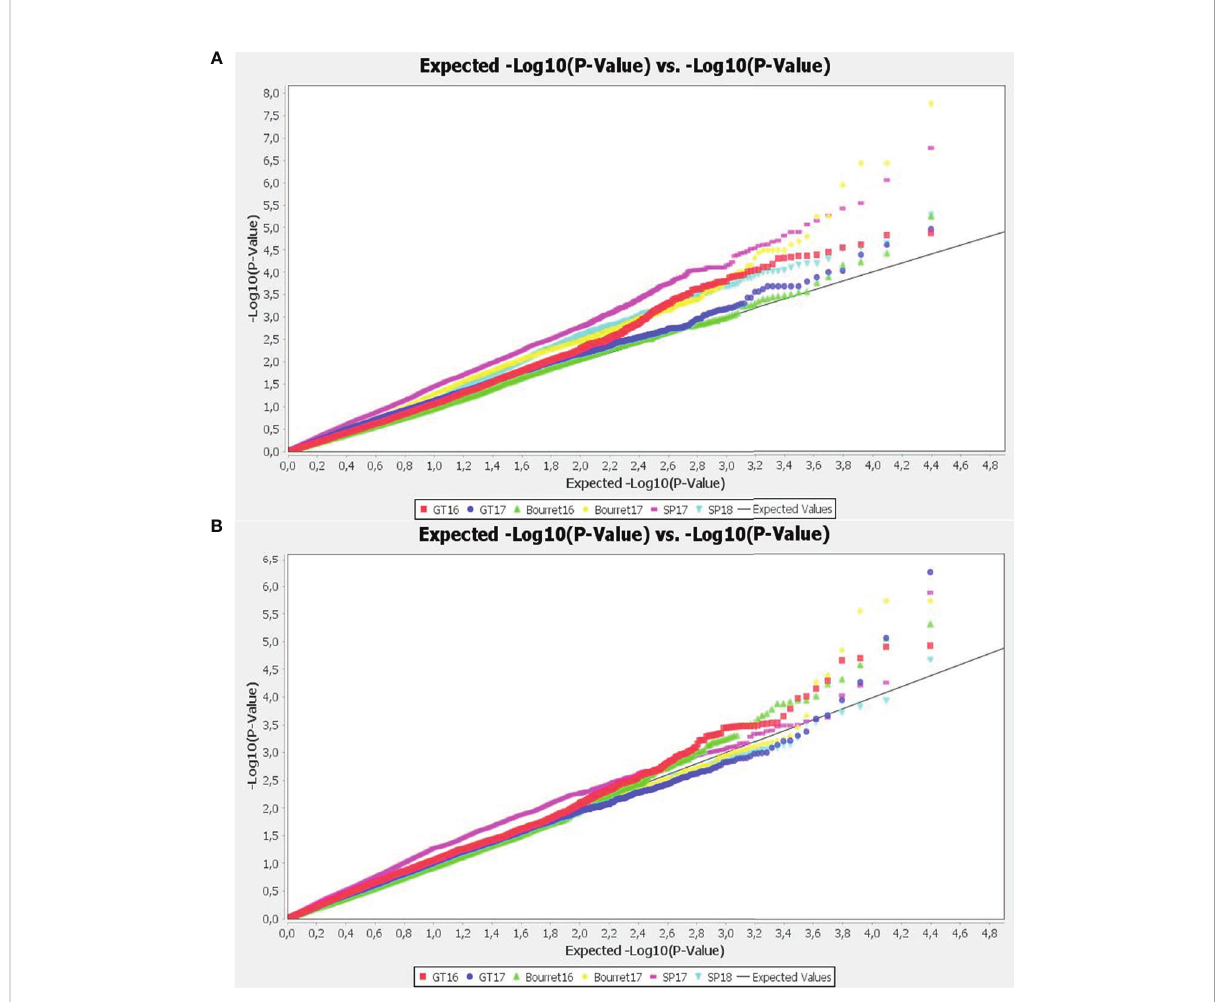
FIGURE 3 Quantile-quantile (Q-Q) plots of observed versus expected P values of the GWAS results using GLM+PCA (A) and MLM+K+PCA (B) . The straight line represents concordance of observed and expected